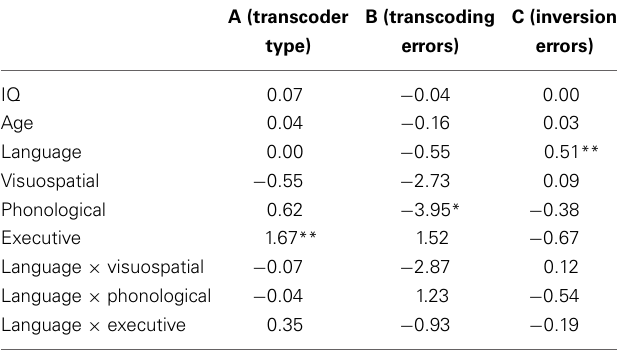
Table 4 | Standardized beta values of the three regression